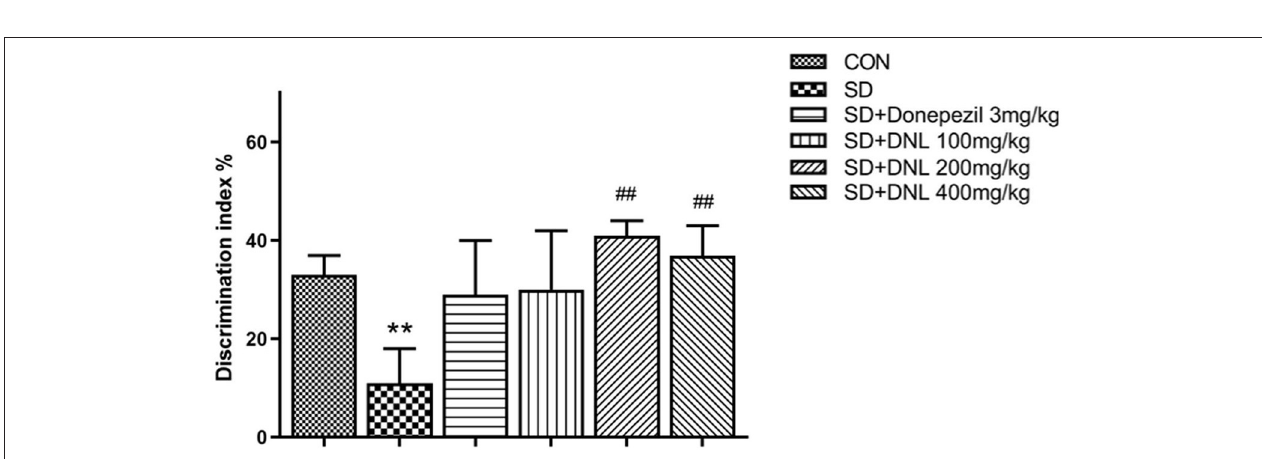
FIGURE 5 | The effect of DNL on the discrimination index (DI) during the testing session in the OLR task after SD for 2 weeks in mice. Values are mean ± SEM, n = 10–12. ** p < 0.01 vs. the Con group; ## p < 0.01 vs. the SD